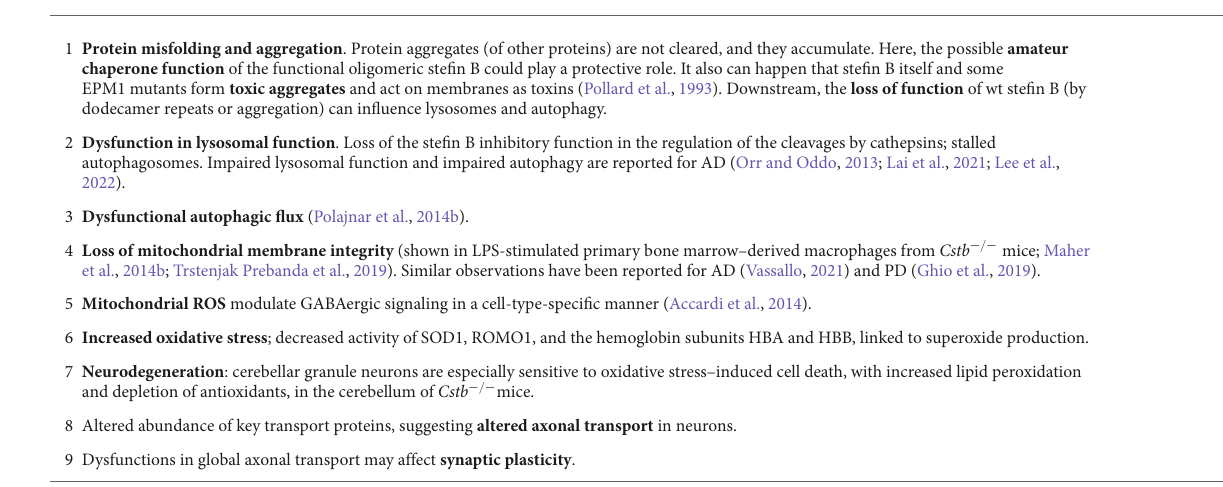
TABLE 1 Development of EPM1 pathology from stefin B loss and gain of functions; central role of protein misfolding and aggregation.